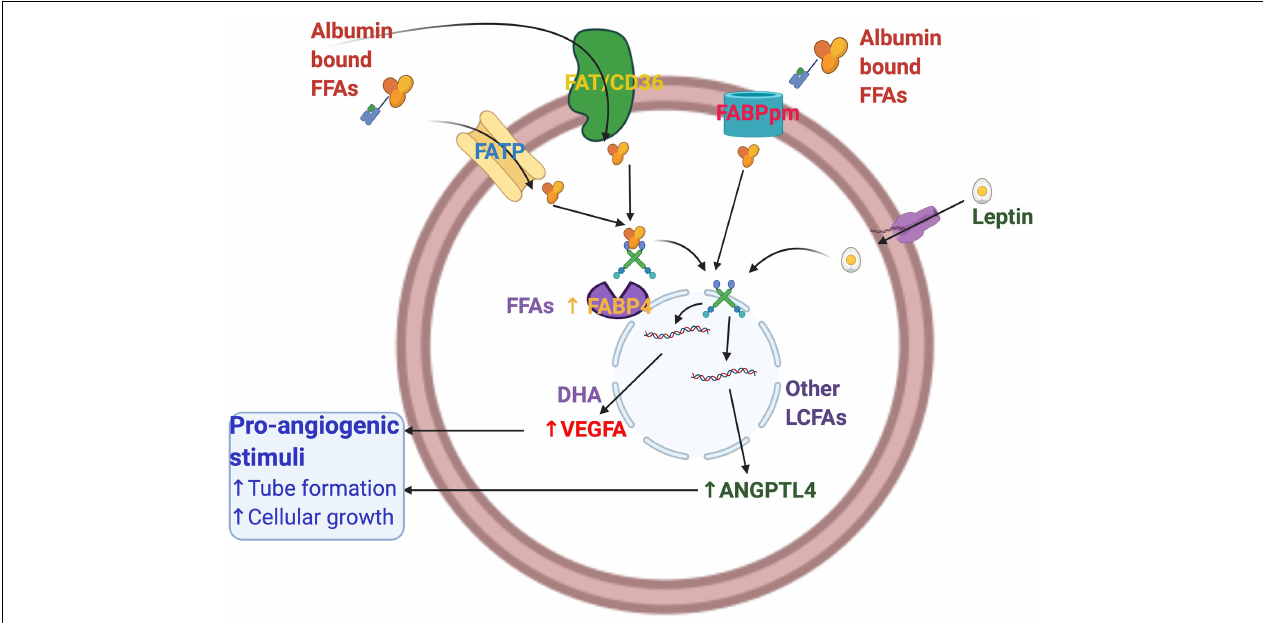
FIGURE 3 | Fatty acid-induced angiogenesis in the human placental first-trimester trophoblasts. Proangiogenic growth factors such as ANGPTL4, VEGF, and FABP4 are involved in placental angiogenesis. ANGPTL4 and FABP4 are stimulated by all other long-chain fatty acids, whereas DHA stimulates VEGF. DHA, Docosahexaenoic acid; FABP4, Fatty acid-binding protein 4; VEGF, vascular endothelial growth factor; ANGPTL4, angiopoietin-like protein 4; LCFAs, long-chain fatty